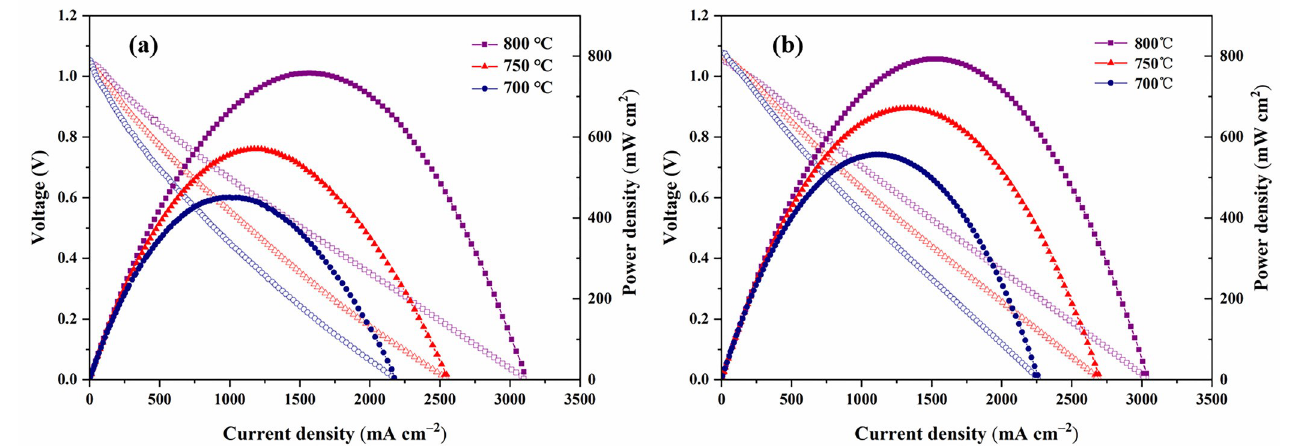
Figure 9. I-V and I-P curves of single cells at different temperatures (700–800 ◦ C) for cathode ( a ) NBCFM and ( b ) NBCFM-30%SDC.